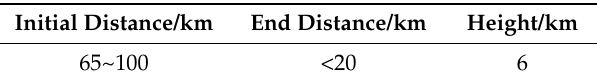
Table 1. Air confrontation